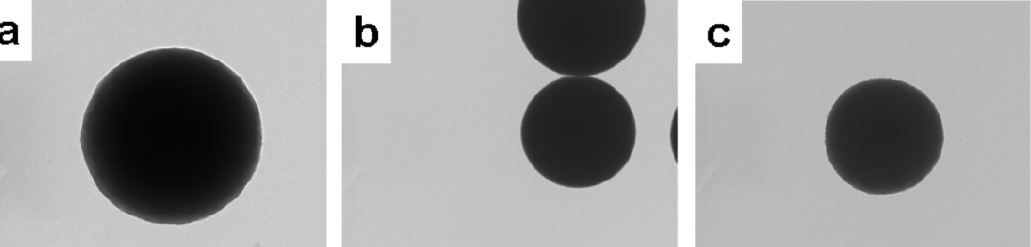
Figure 2. TEM images of polyphosphazene micro-nanospheres: ( a ) 6FPZF micro-nanospheres; ( b ) 3FPZF micro-nanospheres; ( c ) TPZF micro-nanospheres.